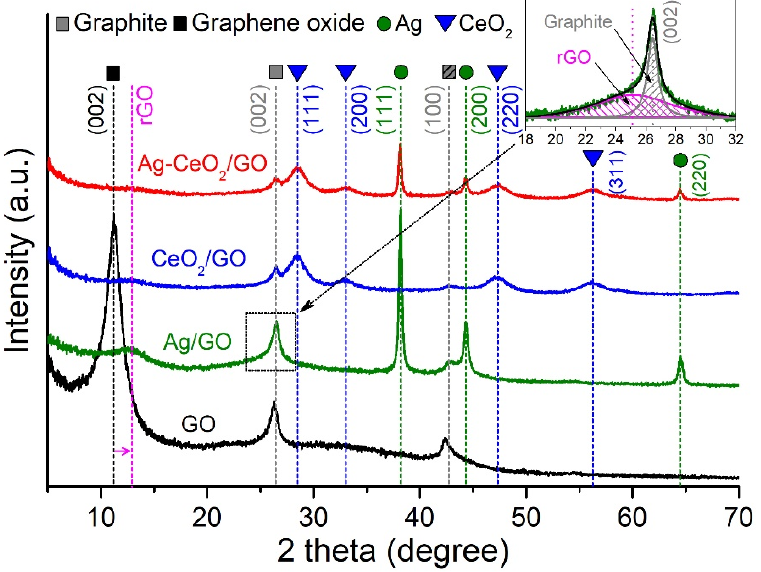
Figure 3. XRD patterns of the synthesized catalysts.